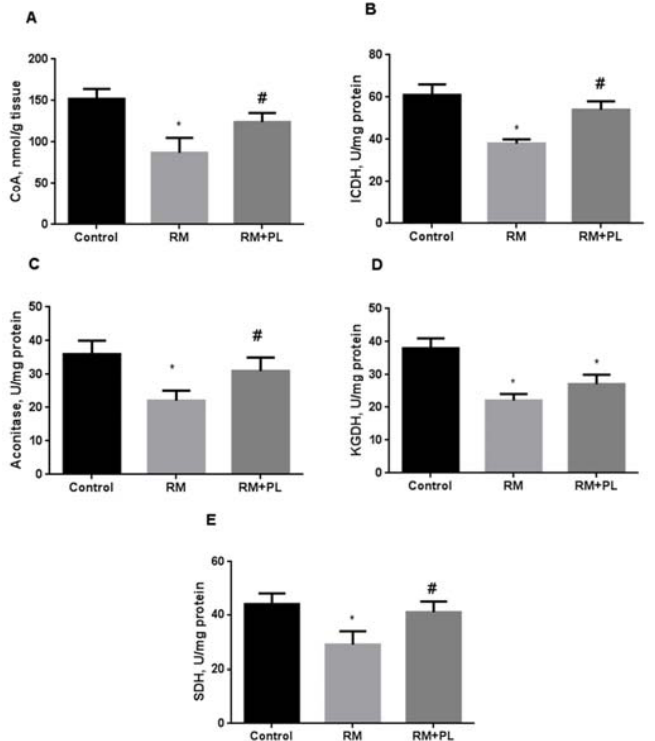
Figure 7. Levels of total CoA in the kidney tissue and the activity of Krebs cycle enzymes in mito- chondria of the kidneys after rhabdomyolysis and PL treatment: ( A ) total CoA levels; ( B ) isocitrate dehydrogenase activity; ( C ) aconitase activity; ( D ) alpha-ketoglutarate dehydrogenase activity; and ( E ) succinate dehydrogenase activity. * p < 0.05 compared to control, # p < 0.05 compared to RM.